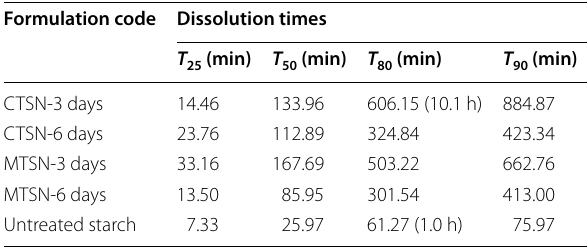
NB, CTSN, Chemically treated starch nanoparticles; MTSN, Mechanically treated starch